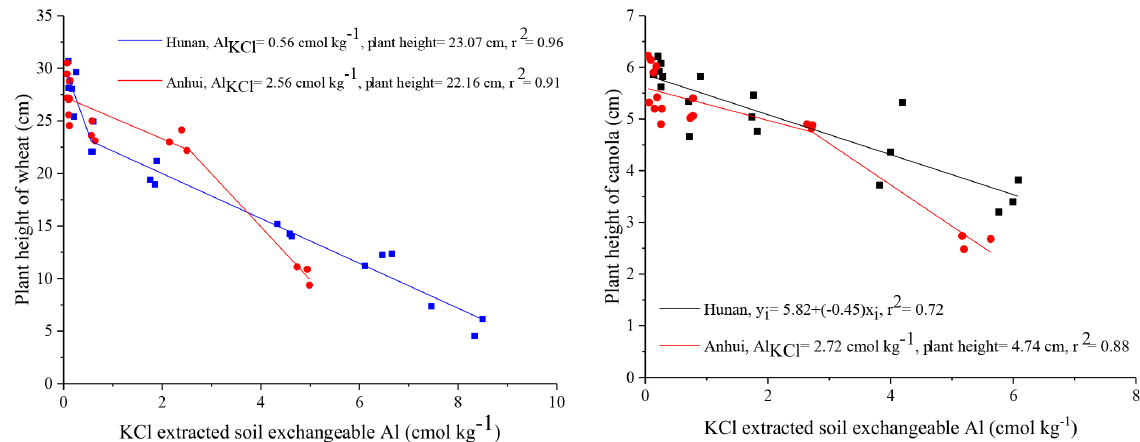
Figure 3. Plant heights of wheat and canola as a function of KCl extracted exchangeable Al of the Ultisols from Hunan and Anhui. The fitted equations were significant at P